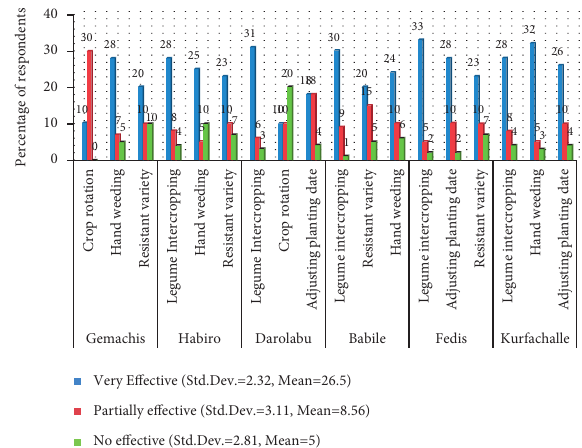
Figure 6: Farmers’ responses on methods used to prevent/control Striga. Table 5: Willingness of the farmers for collective actions to manage Striga in the